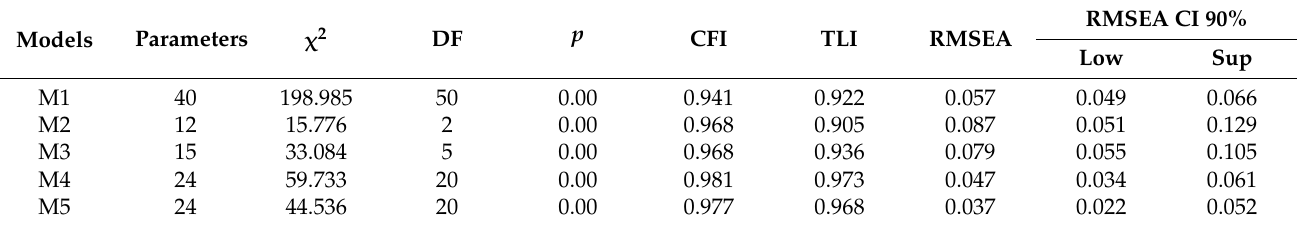
Table 1. Indicators of overall fit of the measurement models and estimated structural models.